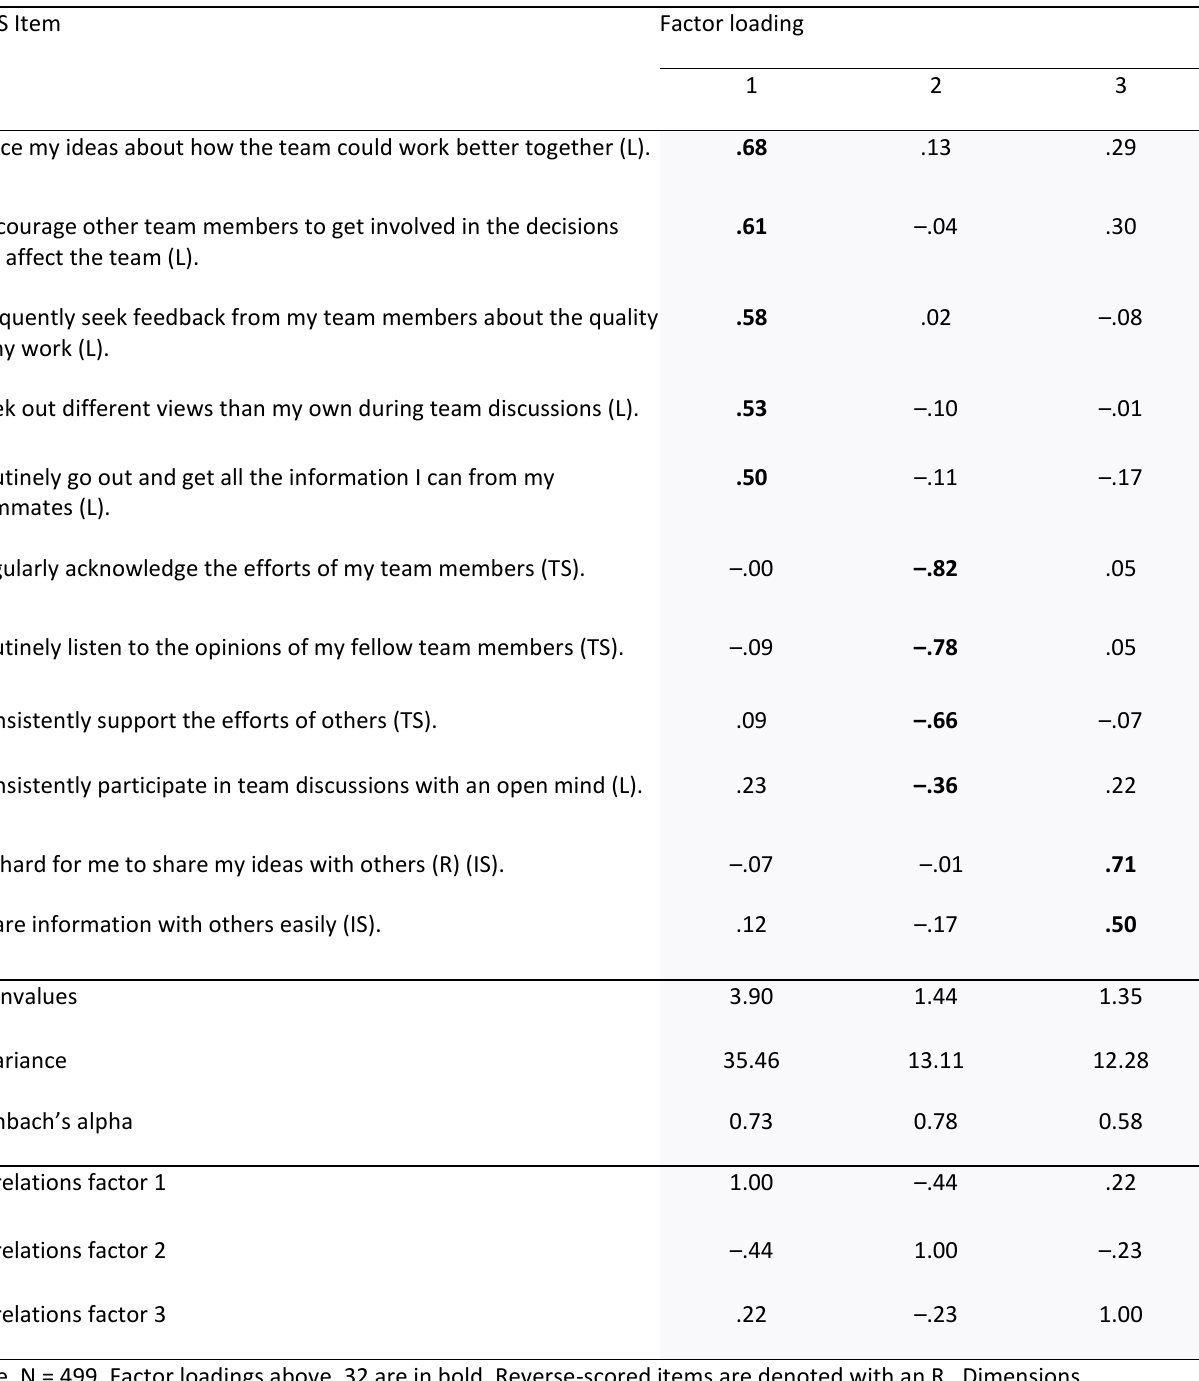
Table 4. Results of an explorative factor analysis on the SACS measure using SPSS, based